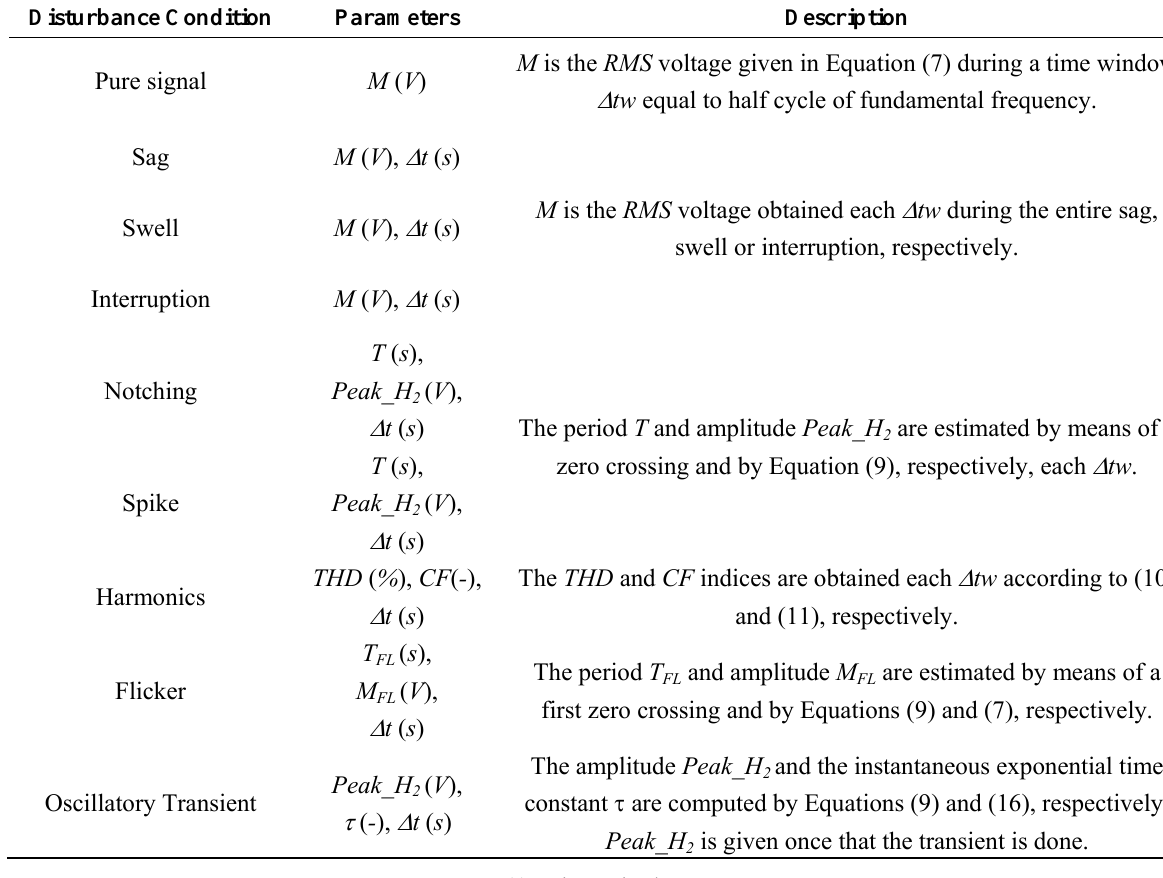
Table 2. Quantification parameters for power quality